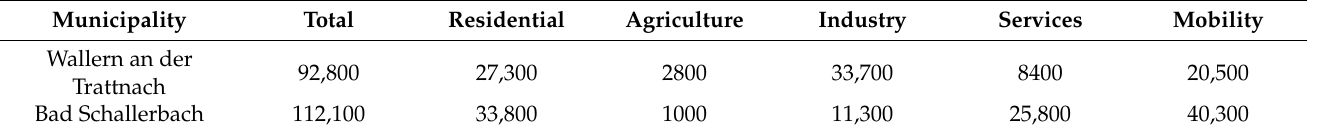
Table 1. Sector specific total energy consumption [MWh/a] of the case study municipalities [31,34]. Municipality Total Residential Agriculture Industry